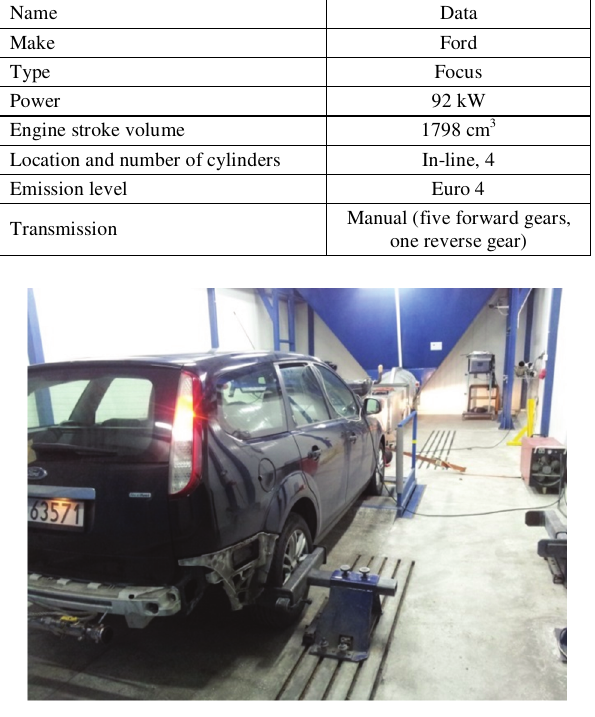
Fig. 1. Ford Focus car on the test